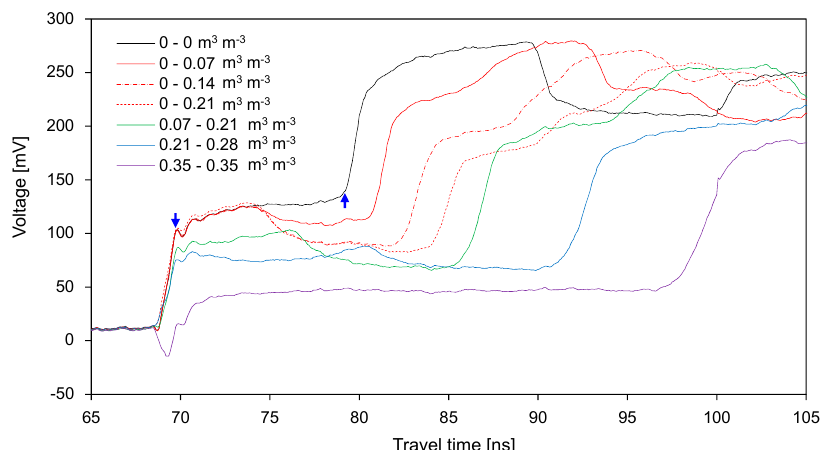
Figure 7. Variance of the signals with the SWC in the dry-wet treatment. The upward and downward arrows denote the end reflection point (t max ) and the time of minimum second order derivative in the first reflection (t min ), respectively.